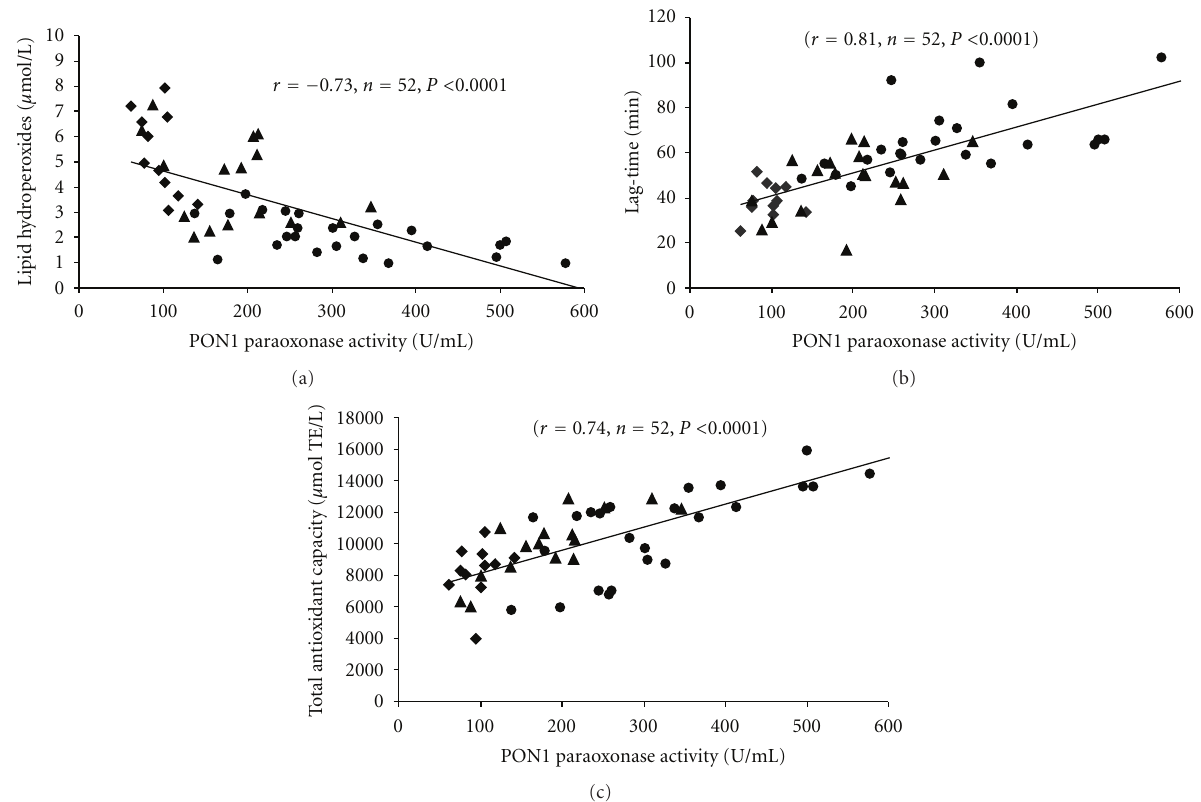
Figure 2: Correlations between PON1 paraoxonase activity versus the concentrations of serum lipid hydroperoxides (a), versus duration of the lag-time of Cu 2+ -oxidized serum (b), versus serum total antioxidant capacity (c) of controls ( • ) and untreated ( (cid:2) ) or GFD-treated ( (cid:3) ) celiac patients.